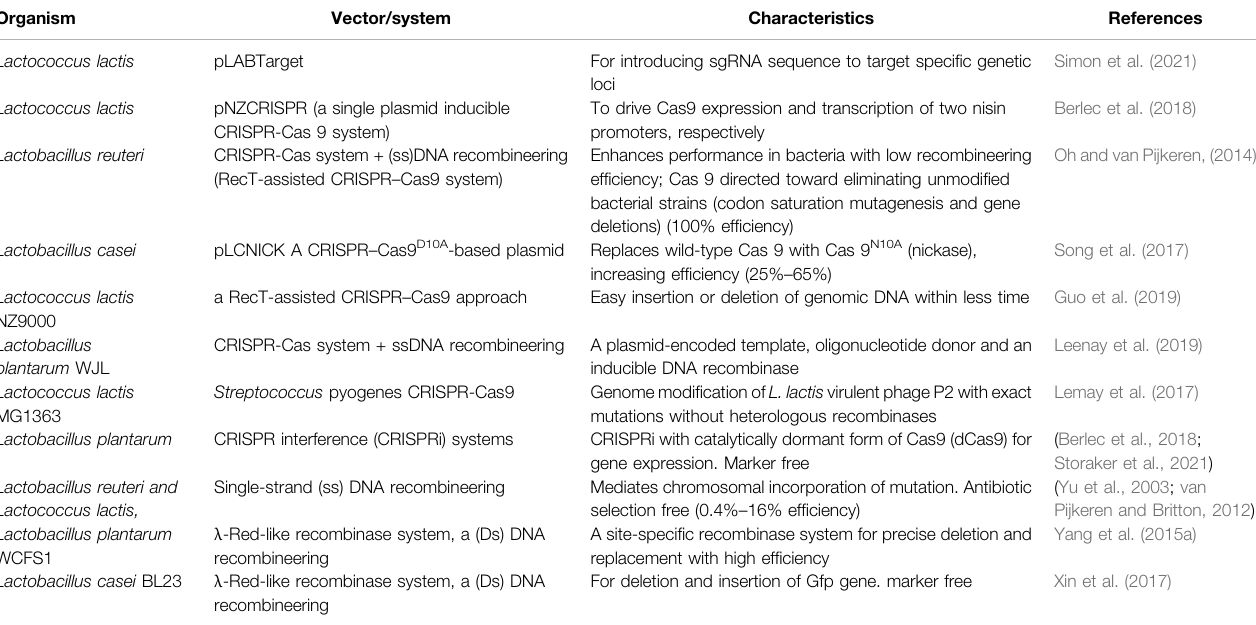
TABLE 2 | New genome engineering possibility with recombineering and CRISPR – Cas system in